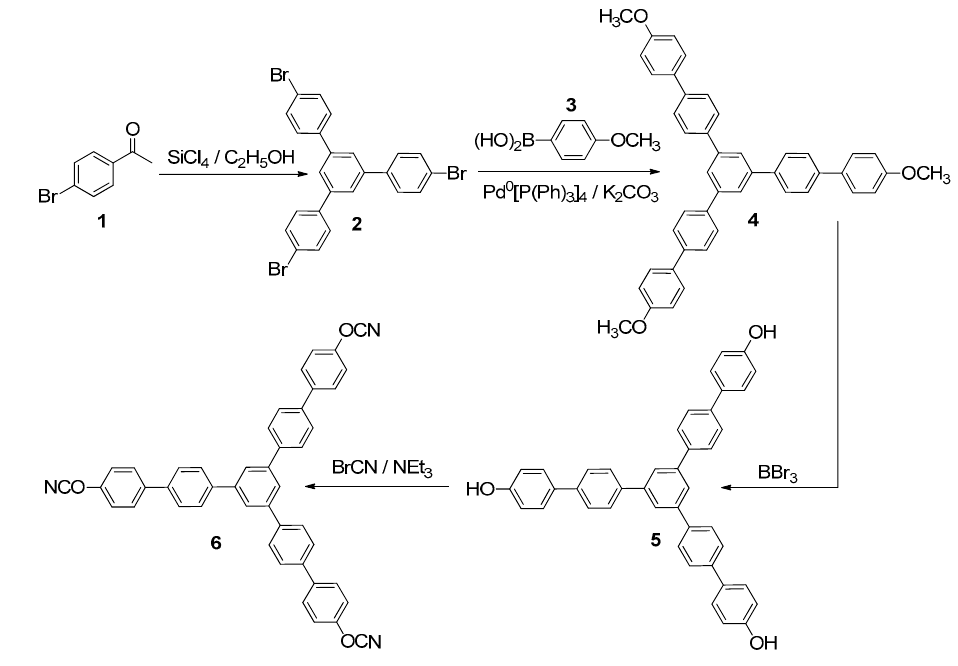
Figure 2. Schematic representation of the target cyanate ester 6 synthesis. Compounds 2–5 were synthesized according to known synthetic protocols described in.